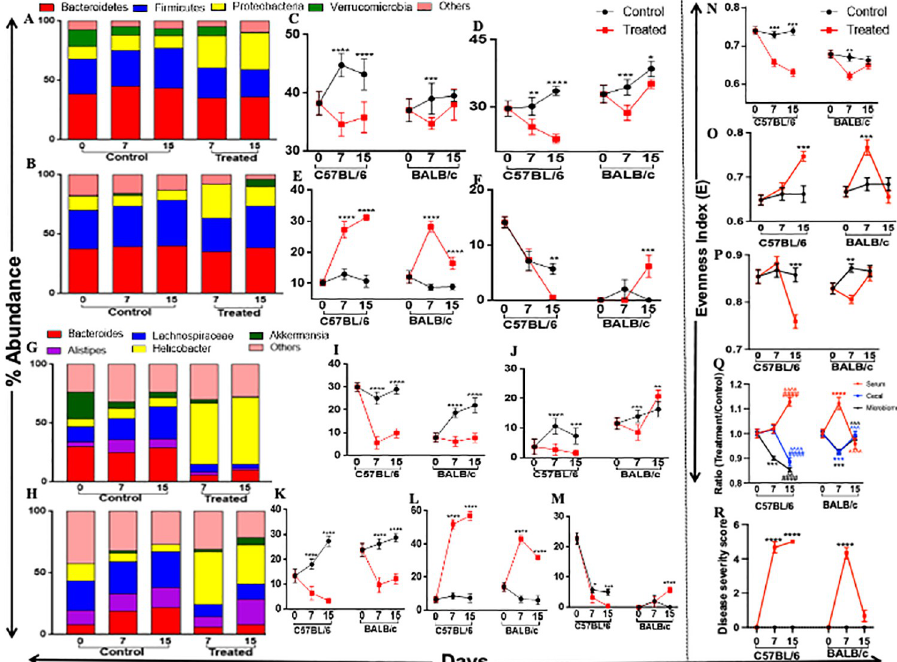
Fig 4. Phylum and genus level changes in gut microbial composition and altered metabolic and microbial diversity due to altered disease severity. Stack bar showing the relative changes in significant phyla of gut microbiota in control and DSS treated C57BL/6 (A) and BALB/c (B) mice. We have plotted the abundance of significant phyla of control and its respective treated group for both the mice strains for better understanding. (C, D, E, F) depicts the following phylum respectively- Bacteroidetes, Firmicutes, Proteobacteria, Verrucomicrobia. Panel (H, I) represents the relative changes in the genus level of gut microbiota in control, and DSS treated C57BL/6 (H) and BALB/c (I) mice. Similarly, like phylum, we have plotted the abundance of the different genus of control and its respective treated group for both the mice strains for better understanding. (I, J, K, L, M) depicts the following genus respectively- Bacteroides, Alisteps, Lachnospiraceae, Helicobacter, Akkermensia. (N) Further, we calculated the changes in gut microbial diversity. We represented the kinetics of phylum-level diversity by calculating the Equitability (Evenness) index (E) of gut microbiota for both control and treated groups of mice for both the strains. Altered gut microbial composition and diversity could be the main reason for the host’s altered metabolic profile and diversity. (O, P) We represented the kinetics of metabolite (O) and meta-metabolite diversity (P) by calculating the equitability index of metabolite and mete-metabolite composition for both control and treated groups C57BL/6 and BALB/c mice. (Q) We also calculated the (treatment/control) ratio of microbial and metabolic Evenness index (E) of C57BL/6 and BALB/c mice to get a comprehensive idea of microbial and metabolic changes based on disease severity. (R) Disease severity score was calculated to get an idea of how altered microbial and metabolic profiles affect disease severity followed by DSS treatment. We presented all values as means ± SEM for 3 biological replicates. We performed Two-way ANOVA followed by the Bonferroni test to determine the significance level. � /#/^ corresponds to P < 0.05, �� /##/^^corresponds to P < 0.01, ��� /###/^^^ corresponds to P < 0.001, ���� /####/^^^^ corresponds to P < 0.0001. (In panel Q, � symbolizes the comparison between day 0 and day 7, # symbolizes the comparison between day 0 and day 15, ^ symbolizes the comparison between day 7 and day